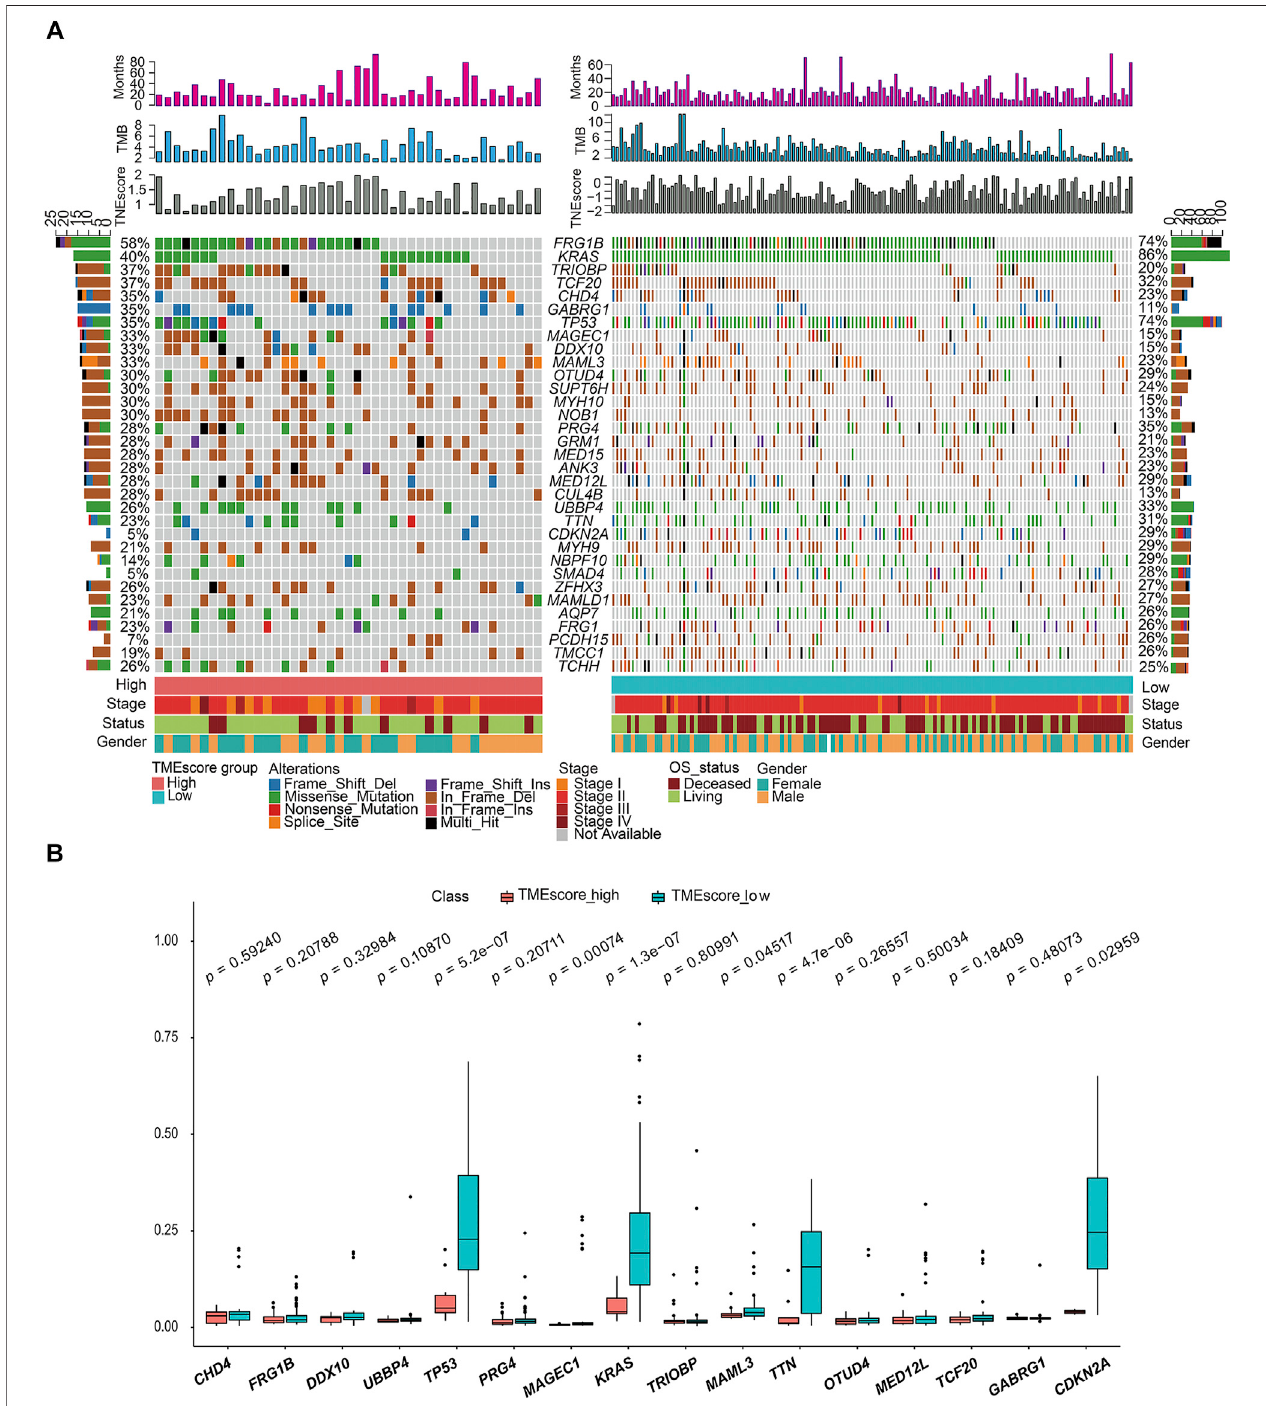
FIGURE 4 | Gene mutation landscape of TMEscore-high and TMEscore-low samples and signi fi cant DEGs. (A) Distribution and phenotype of common gene mutations in tumor samples of high/low TMEscore groups. (B) Analysis of frequency difference of sample gene mutation in TMEscore high/low groups.